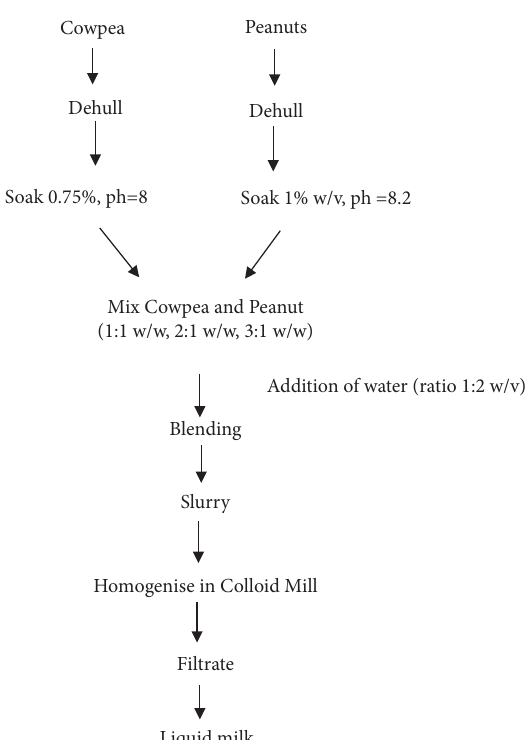
Figure 1: Process flowchart of cowpea-peanut